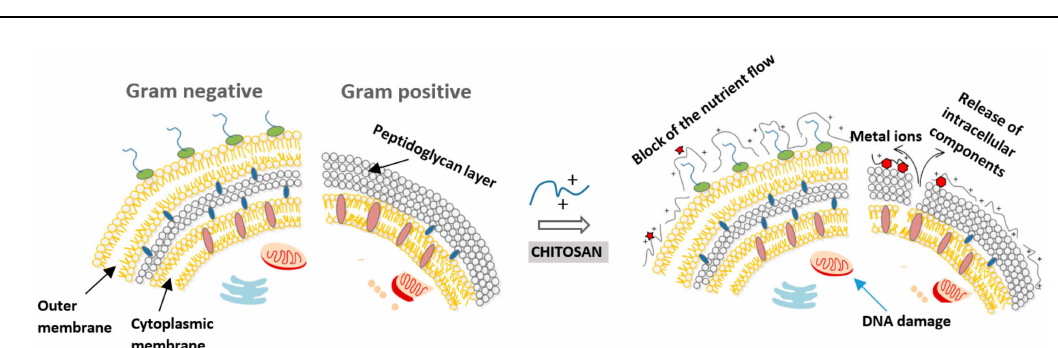
Figure 2. Four proposed models for the action of chitosan on Gram-positive and -negative bacteria: The polycationic nature of chitosan causes the release of intercellular components, binding to bacterial DNA (inhibition of mRNA), blocking the nutrient flow and chelation of essential